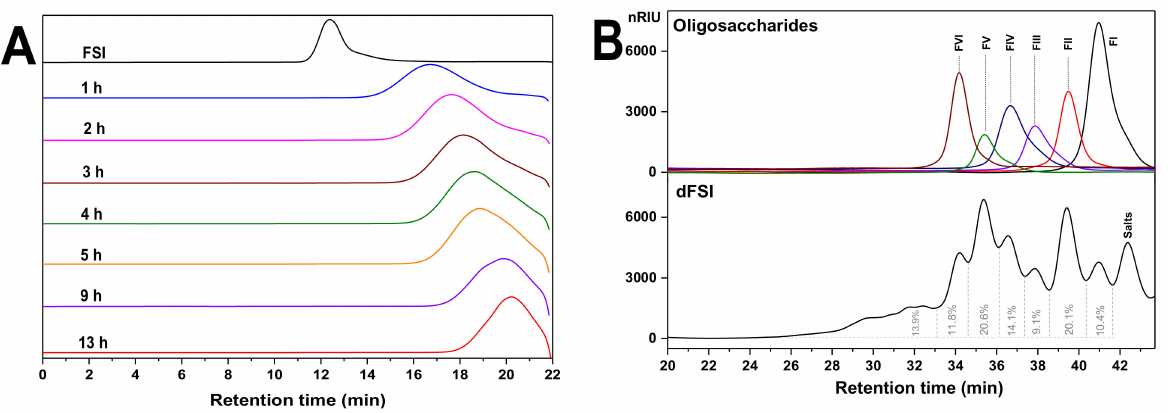
Figure 1. High-performance gel permeation chromatography (HPGPC) profiles of the products released from mild acid hydrolysis of fucan sulfate I (FSI). ( A ) HPGPC of the hydrolyzed products at different times at 80 ◦ C determined on a Shodex OHpak SB-804 HQ column (8.0 mm × 300 mm) eluted with 0.1 M NaCl solution at a flow rate of 0.5 mL/min detected by refractive index detector (RID), respectively. ( B ) HPGPC profiles of mild acid hydrolyzed product (dFSI) and its oligosaccha- rides analyzed on a Superdex peptide 10/300 GL column eluted with 0.2 M NaCl solution at a flow rate of 0.4 mL/min detected by